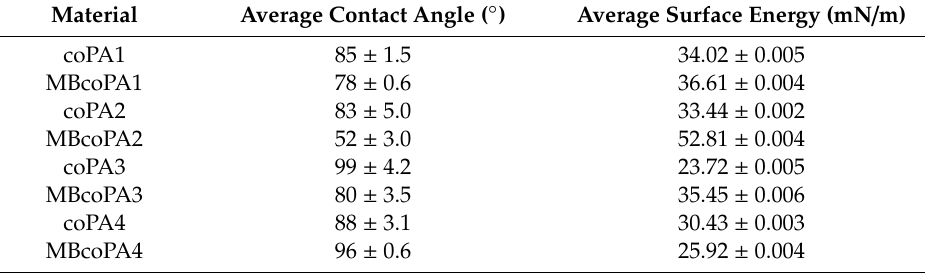
Table 5. Variation in the contact angle and surface energy for the pure coPAs and their masterbatches.